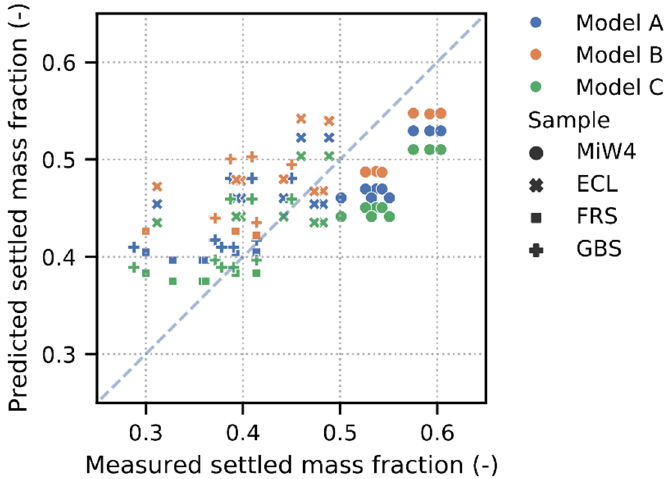
Figure 5. Comparison between measured and predicted settled mass fraction by Models A, B, and C of all samples (MiW4, ECL, FRS, and GBS); n = 33.